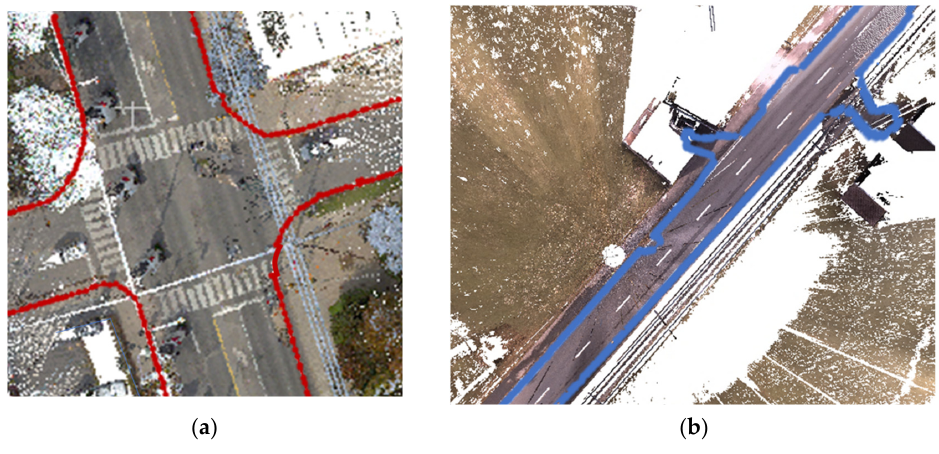
Figure 7. Extraction of the road boundary. ( a ) Intersection; ( b ) road.